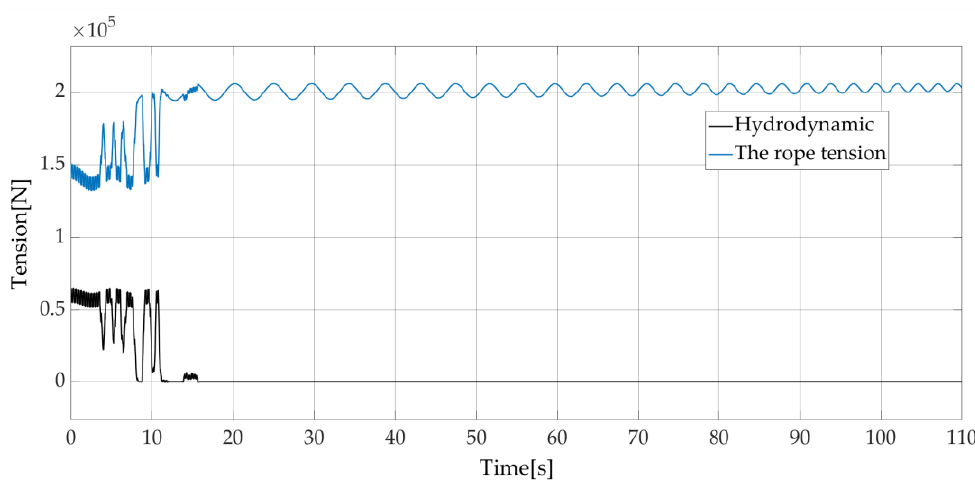
Figure 23. L = 27 m, V = − 0.2 m/s, rope tension and hydrodynamic forces without using adding